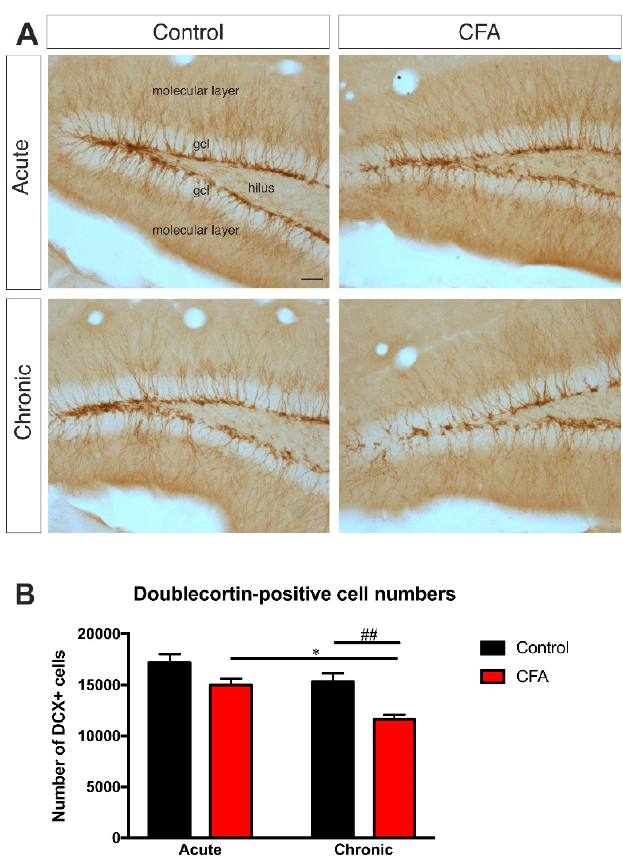
Figure 6. Chronic inflammatory arthritis inhibits adult neurogenesis in the dentate gyrus. ( A ) Representative images demonstrating doublecortin-immunopositive immature neurons in the dentate gyrus of control and CFA-treated mice. Scale bar: 50 µm for all images. ( B ) Results of the systematic cell quantification data. Graphs represent the total number of doublecortin-positive cells in the dentate gyrus of both hemispheres combined. Animals in the CFA-induced chronic arthritis group had a significantly reduced number of DCX-positive cell numbers. Statistics: two-way ANOVA (time × CFA treatment) followed by Tukey’s multiple comparisons post hoc test. * p < 0.05 versus the Acute